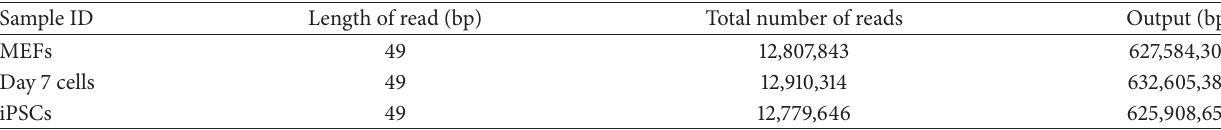
Table 1: Clean data output from H2A.Z ChIP-Sequence.